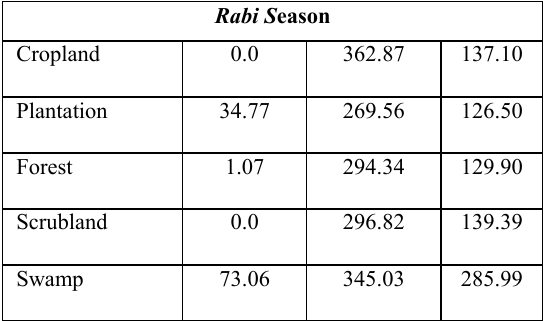
Table 5. Zonal Averaged Rainfall over the Land Covers of Tamil Nadu during the Rabi season of